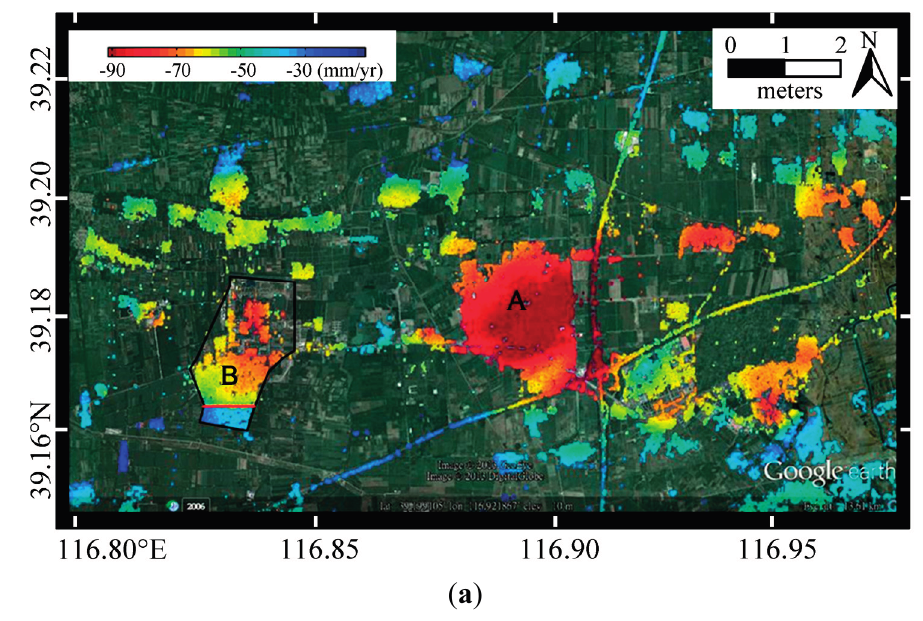
Figure 8. Multi-band combination analysis in Wangqingtuo Town and Donggugang Town. Figure 5a. The color scale ranges from − 90 to − 10 mm/year. A: Wangqingtuo Town; B: Donggugang Town; red line: border line of different subsidence rates; ( b ) The average velocity map of these two towns from ALOS-PALSAR QPS analysis. The color scale ranges from − 190 to − 10 mm/year; ( c ) The background is the average velocity map of Donggugang Town and the red frame plots the location of Shengbao Steel Pipe. The water towers are marked with pink stars and located in the purple